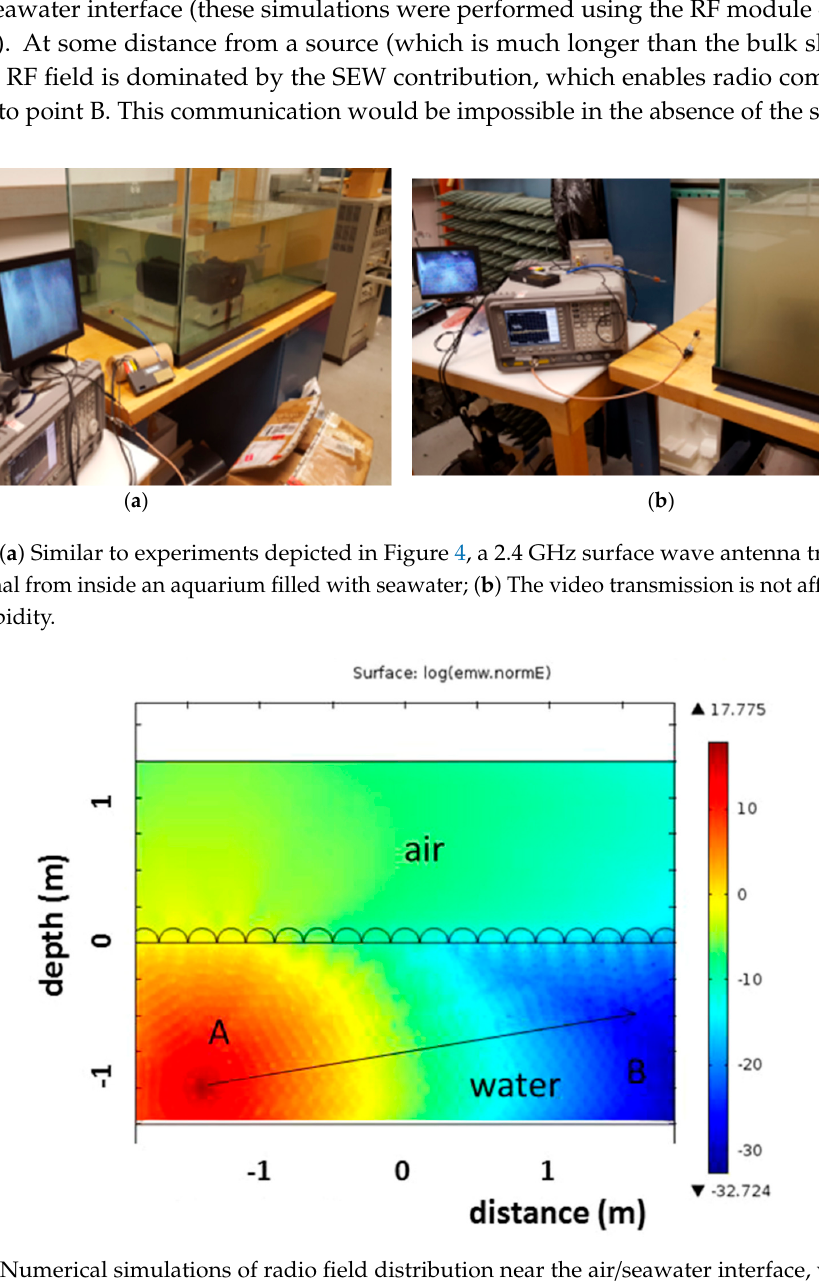
( b ) Figure 7. ( a ) The Wi-Fi underwater video transmitter is moved beyond the free space communication range in a seawater aquarium with still water surface; ( b ) The video link is re-established when the seawater surface is agitated. Directionality of SEW beams, which is also well known in plasmonics [6,10] may further improve performance of underwater RF communication links, since it may to some extent alleviate deterioration of link performance due to high propagation losses in seawater. We were able to demonstrate directional excitation and propagation of SEW waves in model experiments performed in a freshwater aquarium in laboratory settings, as illustrated in Figure 8.